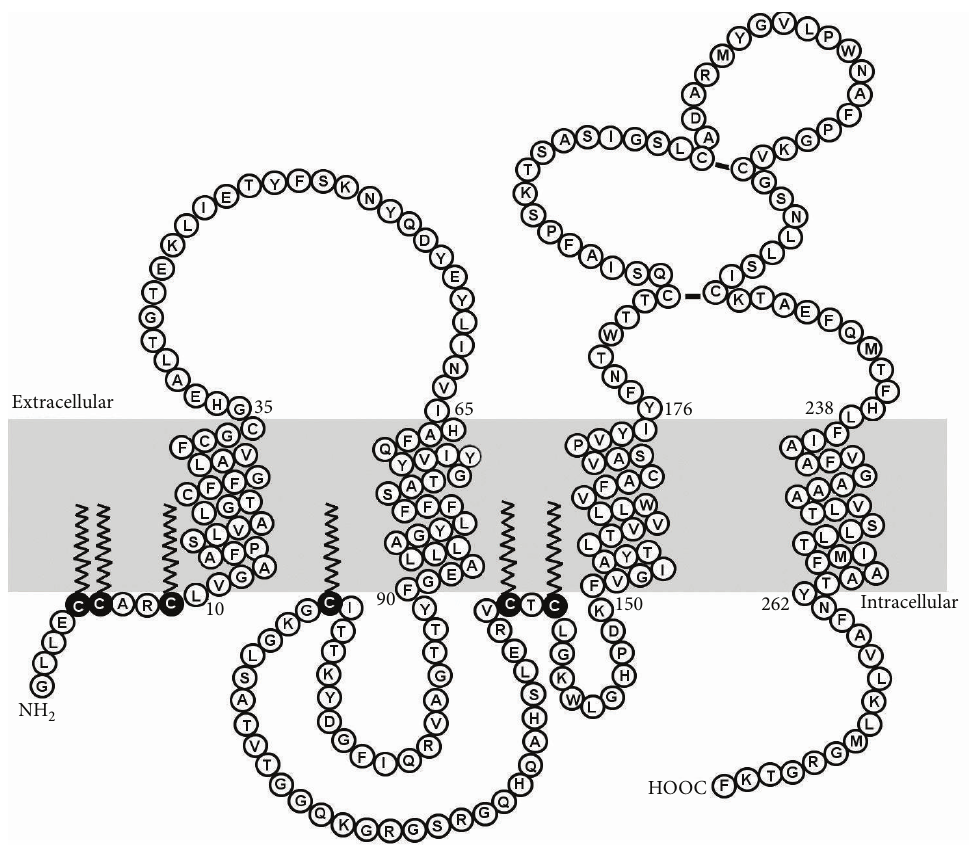
Figure 2: Topology of PLP in the membrane (shaded area). Amino acids are indicated using the single letter code. Cysteine residues that are thioacylated in vivo are shown as black circles with C printed in white, with the lipid tail shown as a zigzag